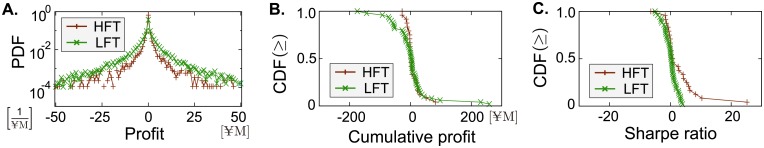
Illustrating the profit distributions and the trading performances of HFTs and LFTs.A,B,C Trading profits and trading performances of banks, the traders in the high-performance cluster of which are aggregated. We exclude from the aggregation traders with transaction counts below 100 in the week. Specifically, (A)–(C) plots the trading profit distributions per trader calculated every 20 minutes during a week, the cumulative profit distributions at the end of the week, and the distribution of the trading performances measured by the Sharpe ratio.